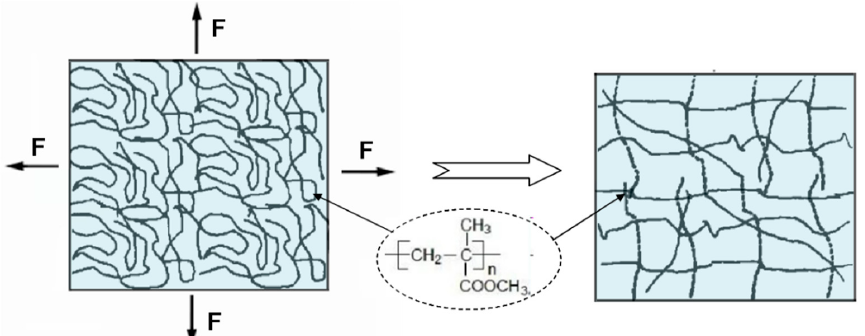
Figure 1. Comparison of molecular chains of nondirectional polymethylmethacrylate and directional polymethylmethacrylate after processing.